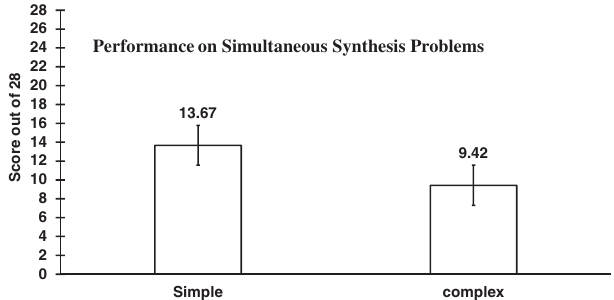
FIG. 12. Overall performance on the two simultaneous syn- thesis tasks. Error bars represent standard